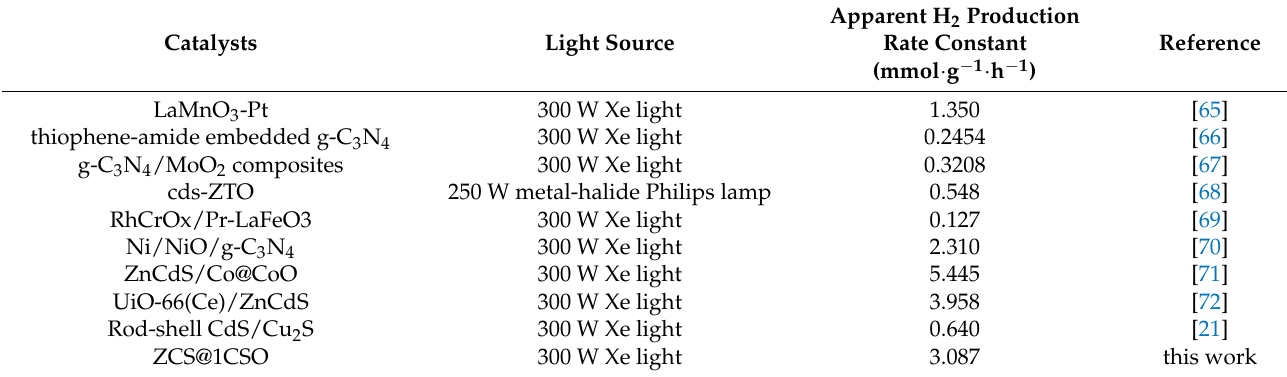
Table 3. The hydrogen evolution performance of recent